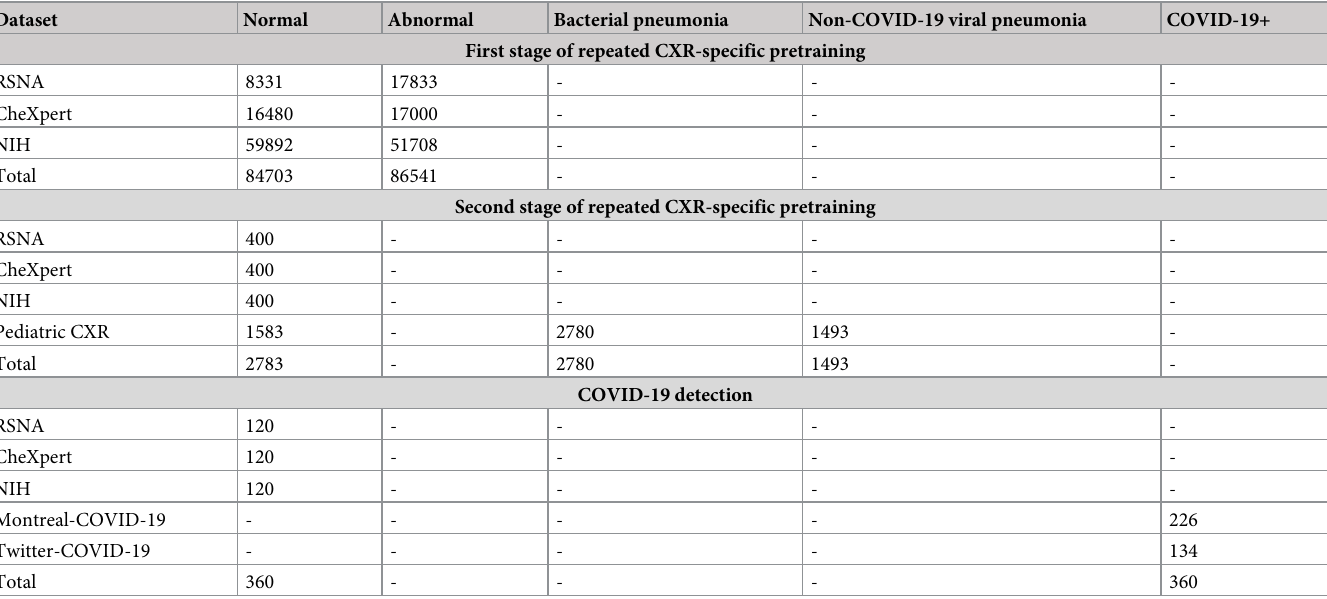
Table 2. Datasets and their distribution used in various stages of learning.